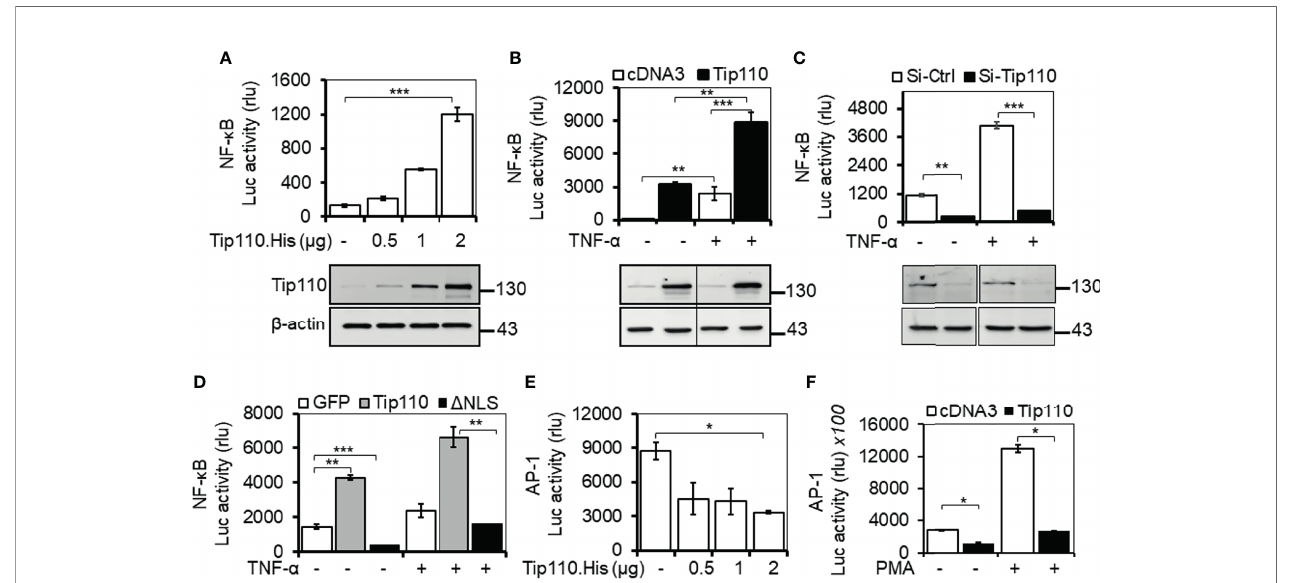
FIGURE 1 | Impact of Tip110 on NF- k B transcriptional activity. (A-D) . 293T were transfected with 0.06 µg pGL3-NF- k B(3)-luc and an increasing amount of Tip110. His (A), 2.5 µg Tip110.His (B), 50 nM Tip110-speci fi c siRNA (si-Tip110) (C) , or 2 µg pGFP.Tip110 or pGFP.Tip110 D NLS containing deletion of the nuclear localization signal (NLS) (D) . (E, F) 293T were transfected with 0.04 µg pAP-1-Luc and an increasing amount of Tip110.His (E) or 2.5 µg Tip110.His (F) . pcDNA3 (A, B, E, F) , control siRNA (Si-Ctrl, C ), pGFP (D) was used to equalize the total amount of DNA or siRNA among the transfection, and pGFP was added to ensure comparable transfection ef fi ciencies among all transfections. (B – D) , 10 ng/ml TNF- a (F) 100 ng/ml PMA were added 24 hr post-transfection and continued for either 18 or 6 hr, respectively. Cells were then harvested for the luciferase reporter gene assay, and Western blotting was used to determine the expression of Tip110. b - actin was used as an internal loading control (A – C) . The data were means ± SE from triplet samples and representative of three independent experiments. *P<0.05, **P<0.01,